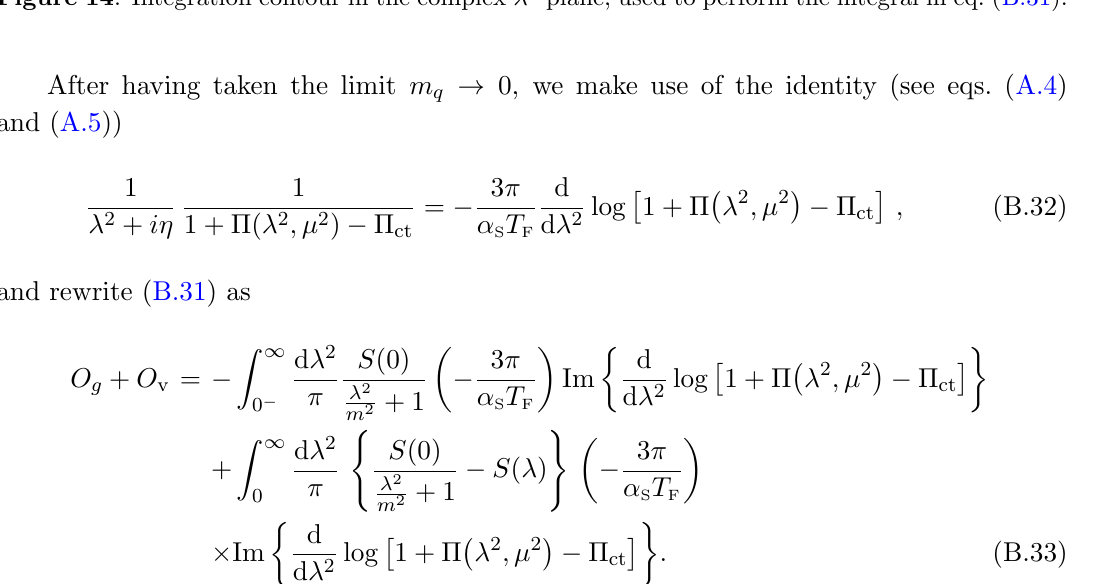
Figure 14 . Integration contour in the complex (cid:21) 2 plane, used to perform the integral in eq. (B.31).